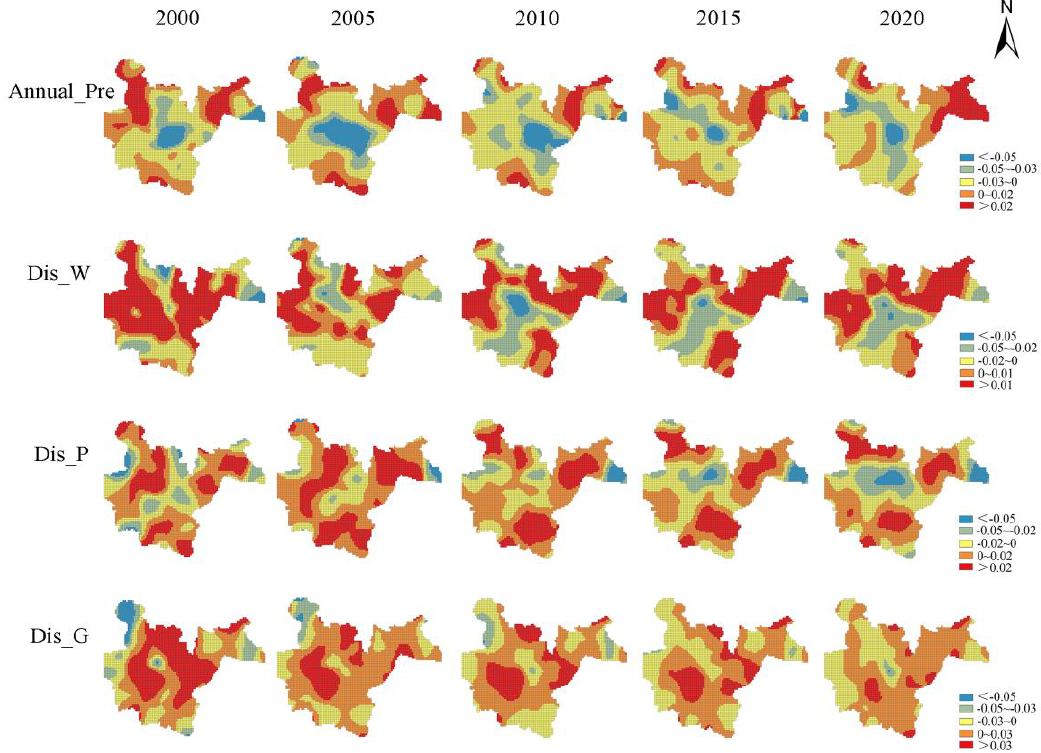
Figure 8. Distribution of regression coefficients of average annual precipitation, and distance to water bodies, parks, and government. bodies, parks, and